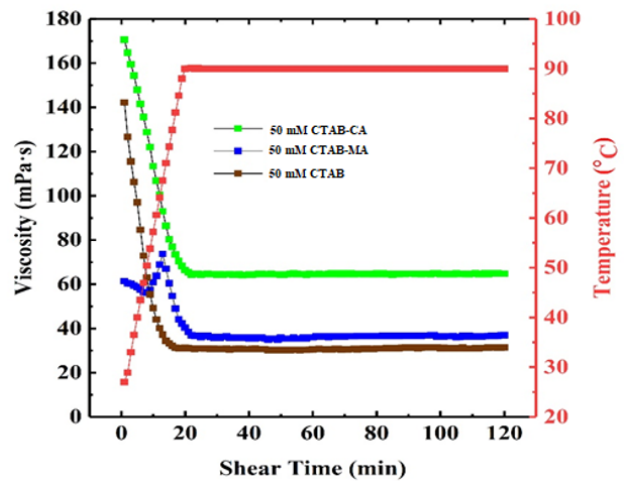
Figure 16. Effect of temperature and alternate shear rate time on the apparent viscosity of VES fluids at shear rate of 170 s − 1